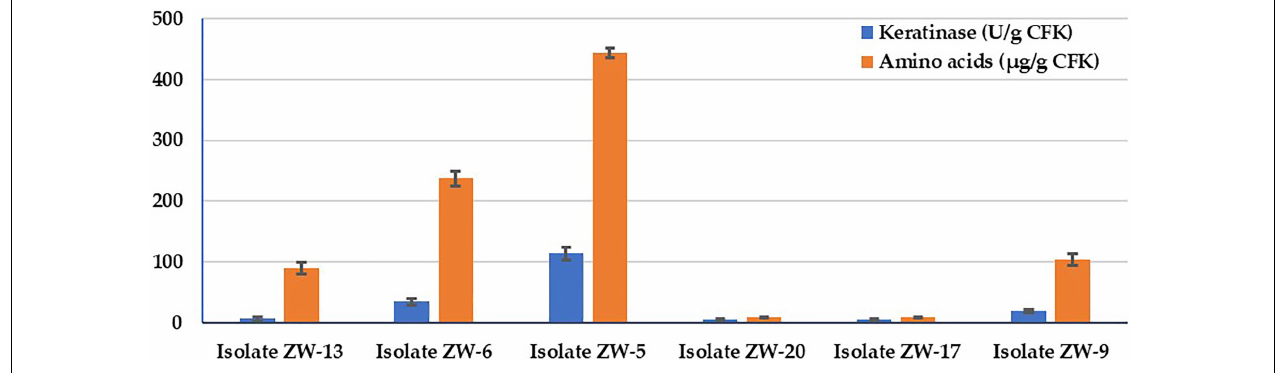
FIGURE 1 | Bacterial screening for keratinase activity and total amino acids produced during fermentation on CFK.